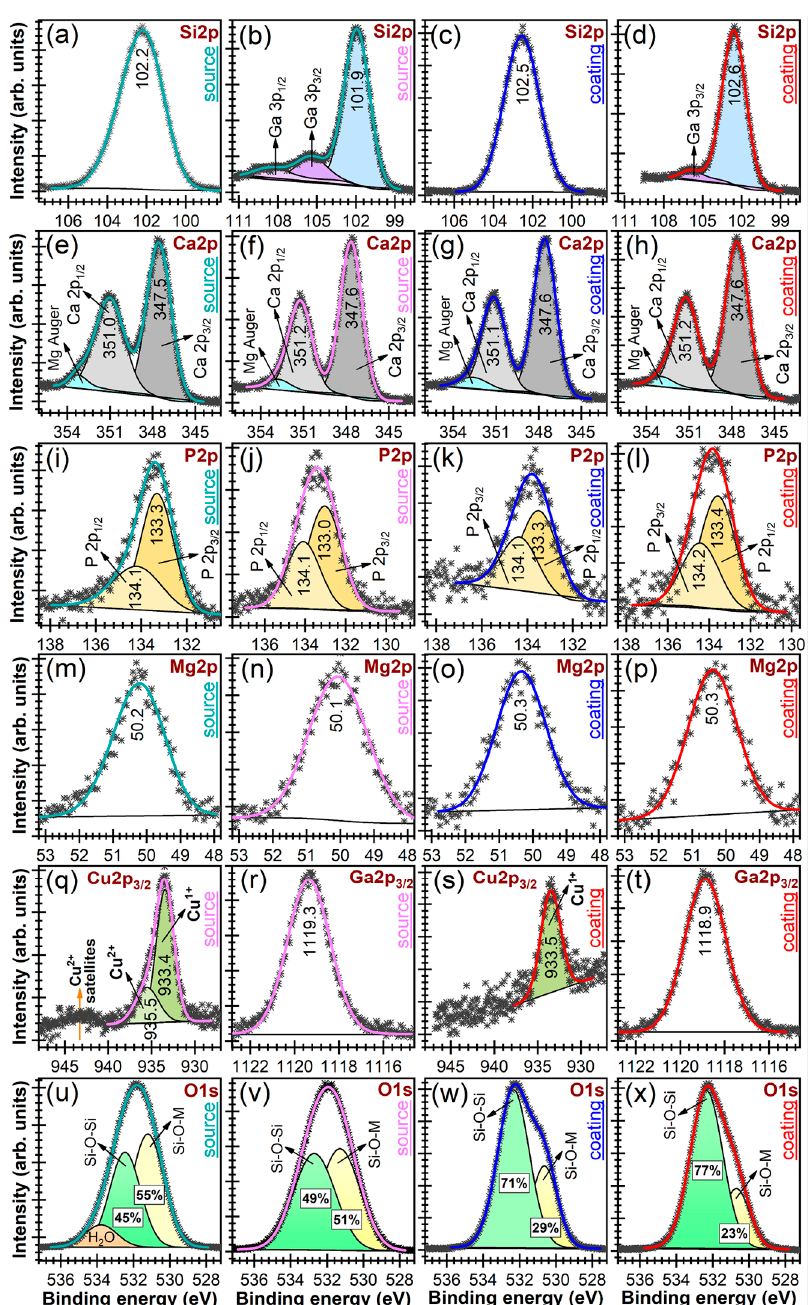
Figure 3. High resolution XPS spectra of the ( a – d ) Si 2p, ( e – h ) Ca 2p, ( i – l ) P 2p, ( m – p ) Mg 2p, ( q , s ) Cu 2p 3/2 , ( r , t ) Ga 3p 3/2 , ( u – x ) O 1s core photoelectron levels, recorded for the ( a , c , e , g , i , k , m , o , u , w ) FastOs ® BG and ( b , d , f , h , j , l , n , p , q – t , v , x ) Cu&Ga-FastOs ® BG ( a , b , e , f , i , j , m , n , q , r , u , v ) source materials and ( c , d , g , h , k , l , o , p , s , t , w , x ) derived films. Symbols: experimental spectrum, Solid line: fit sum. Filled area curves: spectral components.